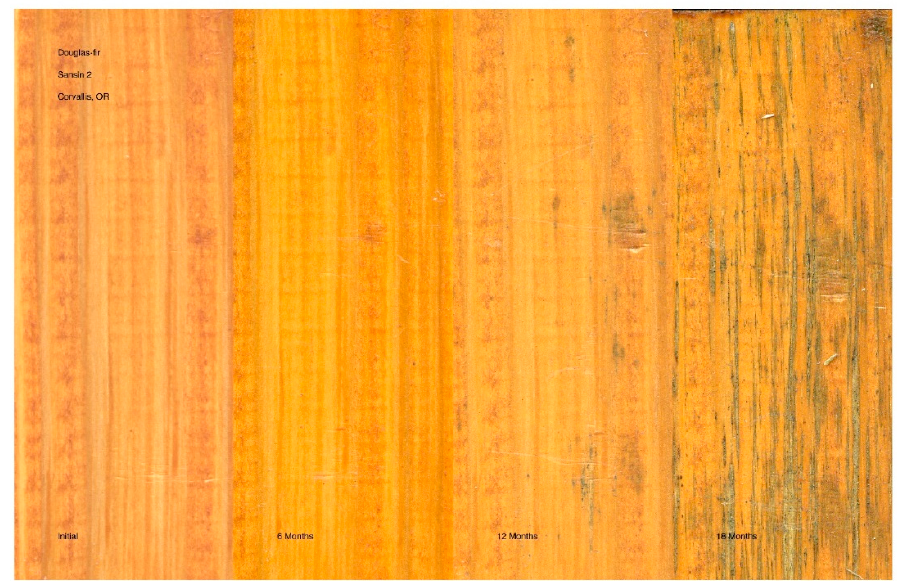
Figure 6. Example of the same Douglas-fir specimen treated with Sansin 2 and exposed outdoors on